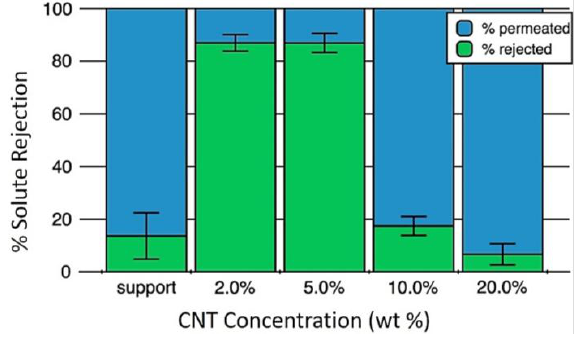
Figure 14. Solute rejection as a function of MWCNT–COOH wt % content with respect to PVA in PVA/MWCNT–COOH composites. Reprinted from [137], with permission from